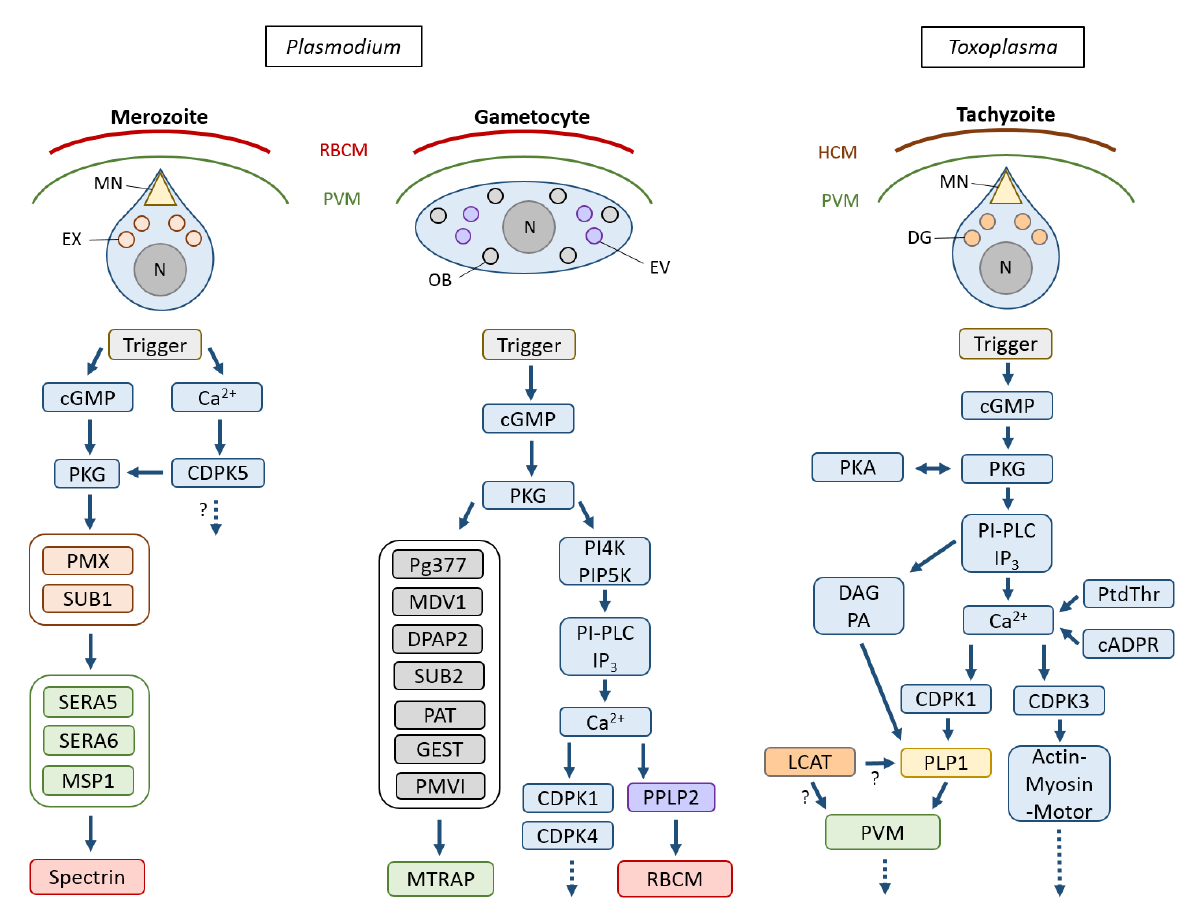
FIGURE 2: Active host cell lysis by Apicomplexan parasites. The key molecules and the sequence of action during host cell egress by mer- ozoites and gametocytes of Plasmodium and by tachyzoites of Toxoplasma gondii , respectively, are indicated. Question marks indicate steps with ambiguous or unknown interactions. DG, dense granule; EV, egress vesicle; EX, exoneme; HCM, host cell membrane; MN, mi- croneme; N, nucleus; OB, osmiophilic body; PVM, parasitophorous vacuole membrane; RBCM, red blood cell